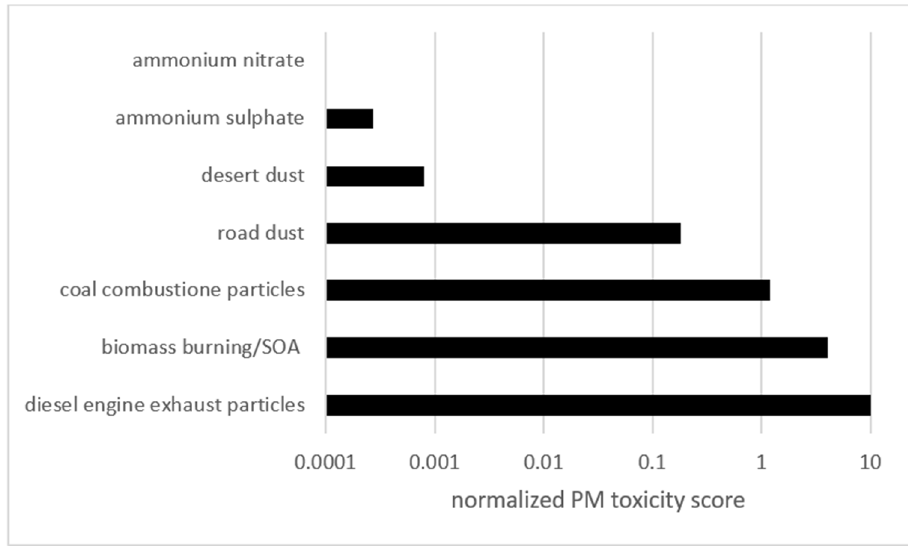
Figure 8. Normalized toxicity score (0 to 10) for source-specific aerosol with differential weights given to the endpoint (data taken from [57]).